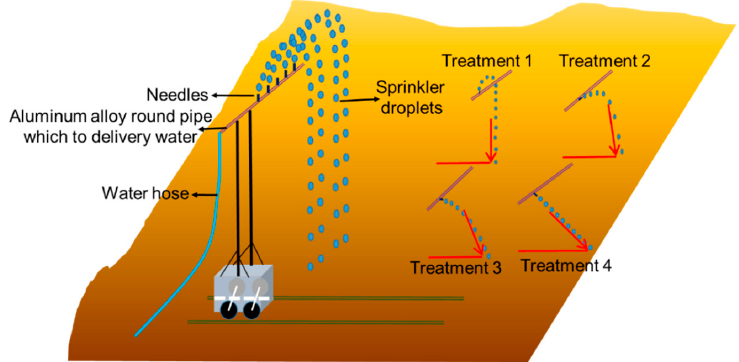
Figure 2. Variation of sprinkler irrigation droplets landing angle.